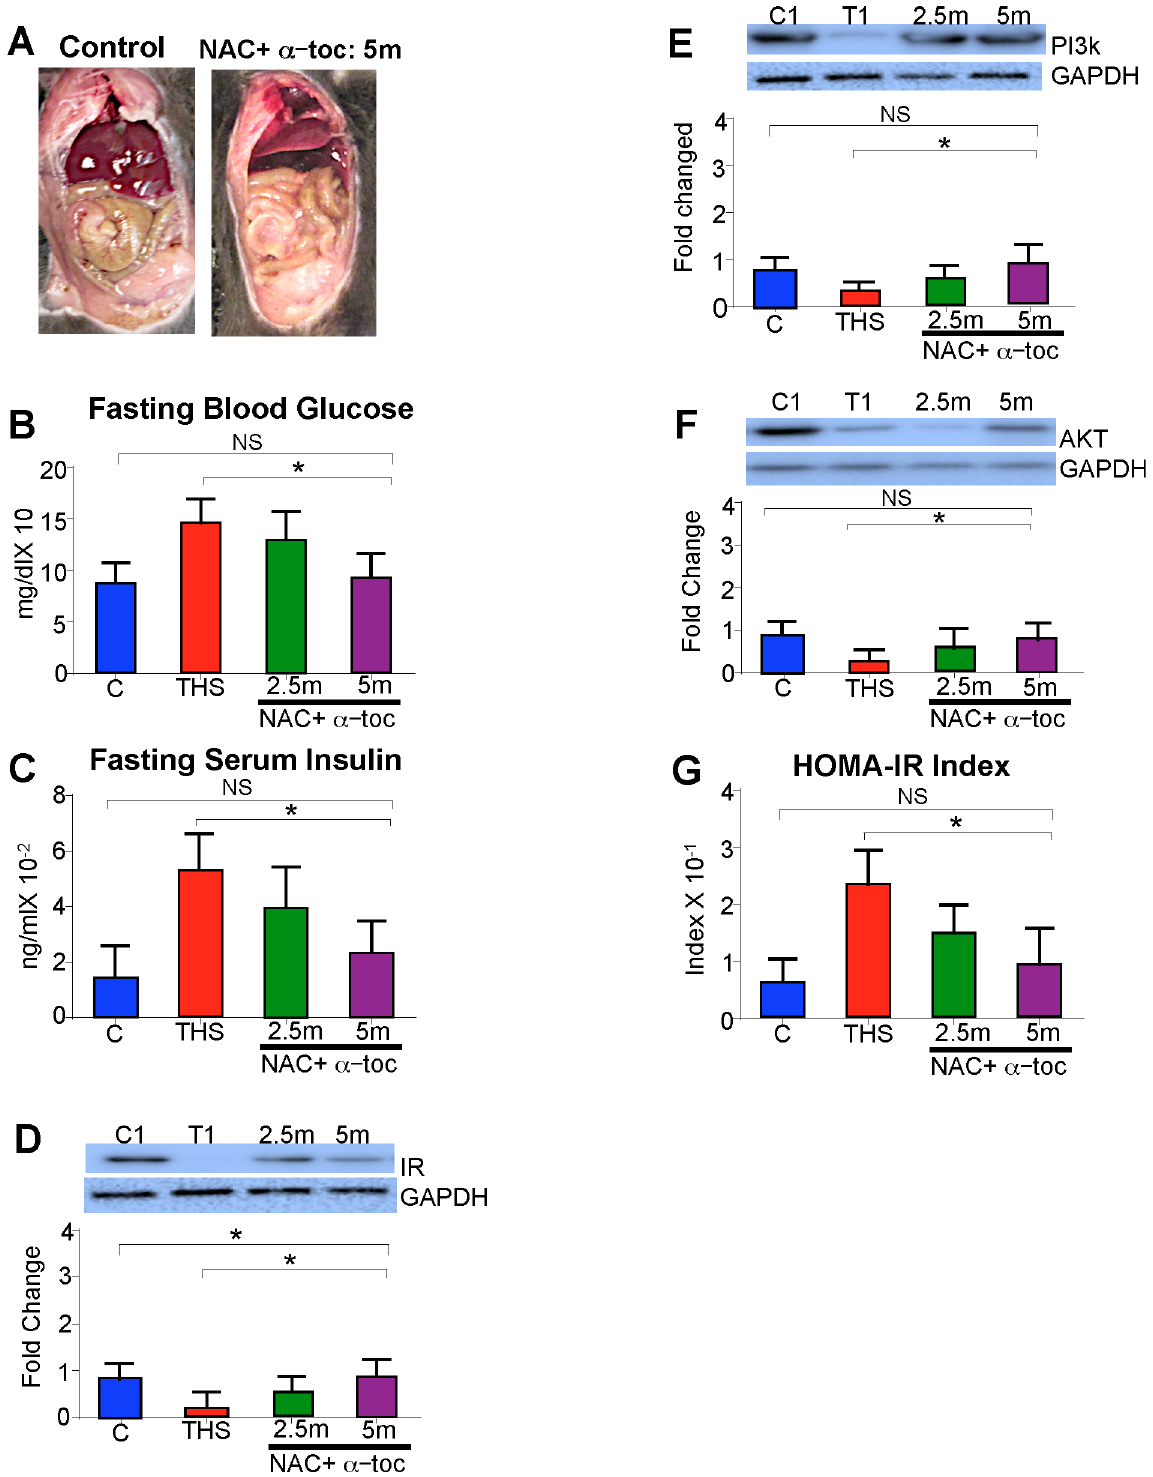
Fig 3. THS exposure in conjunction with antioxidant treatment for 2.5 and 5 months alleviates metabolic syndrome in a dose-dependent manner. (A) THS-exposed mice treated with antioxidants for 5 months have reduced visceral fat accumulation compared to THS exposed mice. Antioxidant+THS treated mice had reduced fasting blood glucose levels (B) , decreased fasting insulin levels (C) , greatly restored protein levels in insulin signaling proteins IR, PI3K and AKT (D-F) , and lower HOMA-IR index (fasting blood glucose X Fasting insulin/22.5) (G) . All data are Mean ± SD * = p < 0.05, ** = p < 0.01. NS = Not